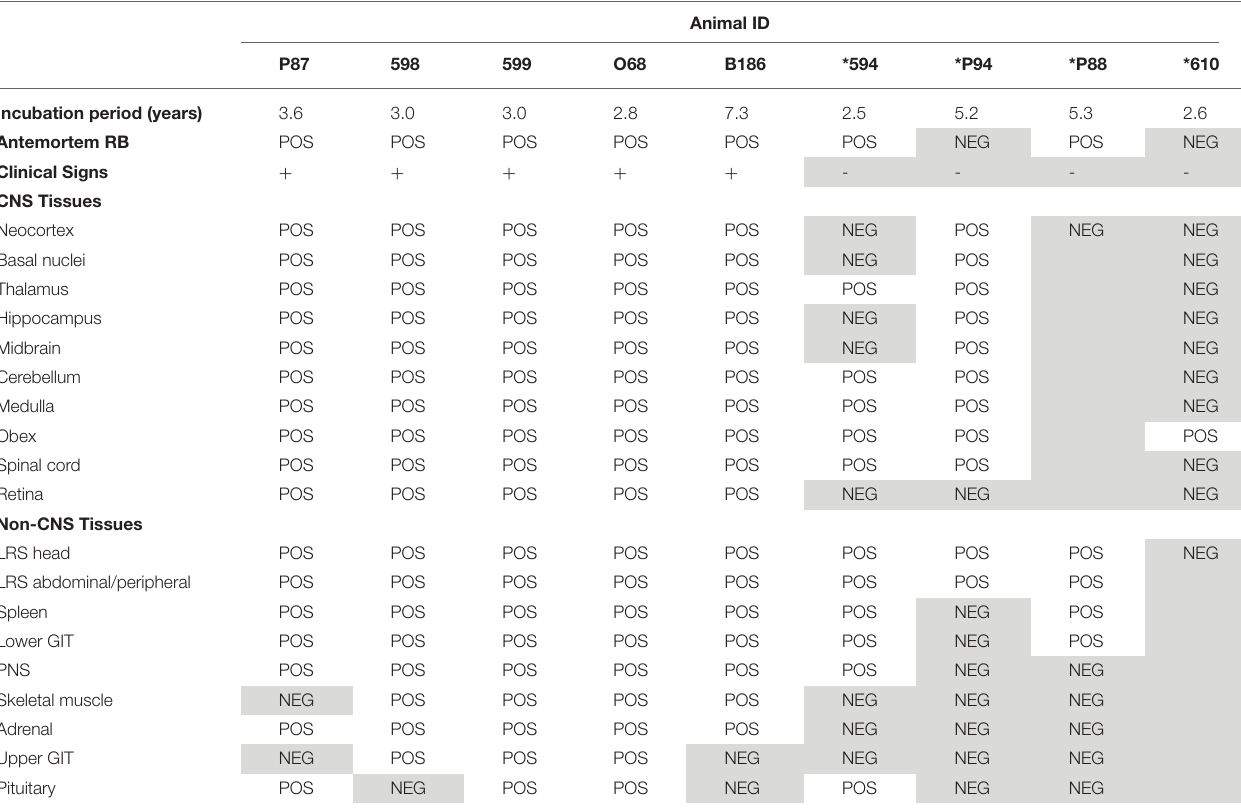
TABLE 2 | Immunohistochemistry of CNS and non-CNS tissues.